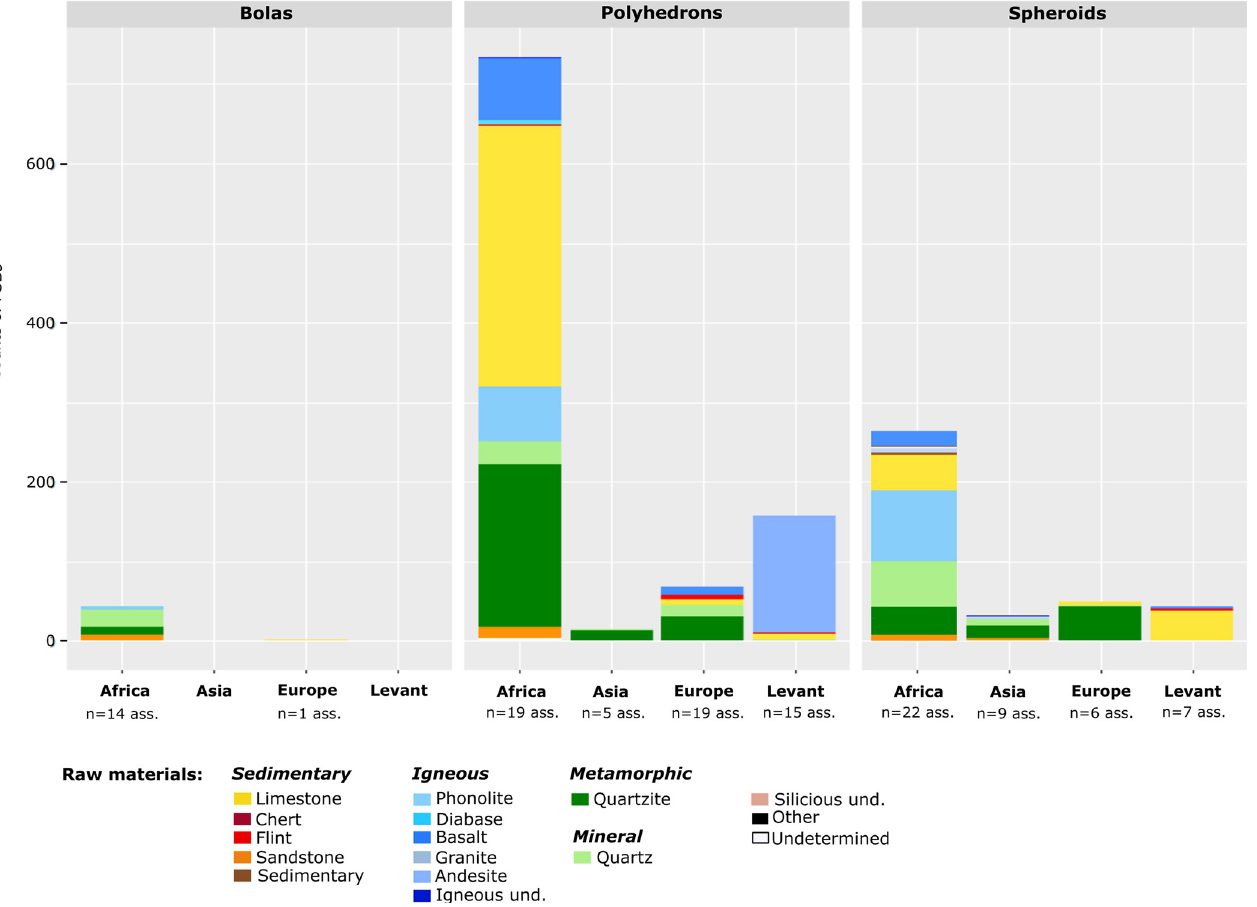
Fig 9. Counts of polyhedrons, spheroids and bolas per raw material in assemblages, in each region. Igneous und.: unspecified igneous rock. Siliceous und.: unspecified siliceous rocks. Sedimentary: breccia and